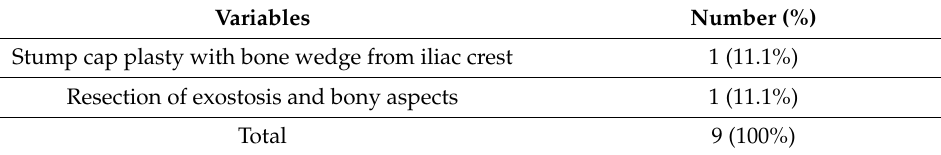
Table 2. Cont. Variables Number (%) Stump cap plasty with bone wedge from iliac crest 1 (11.1%) Resection of exostosis and bony aspects 1 (11.1%) Total 9